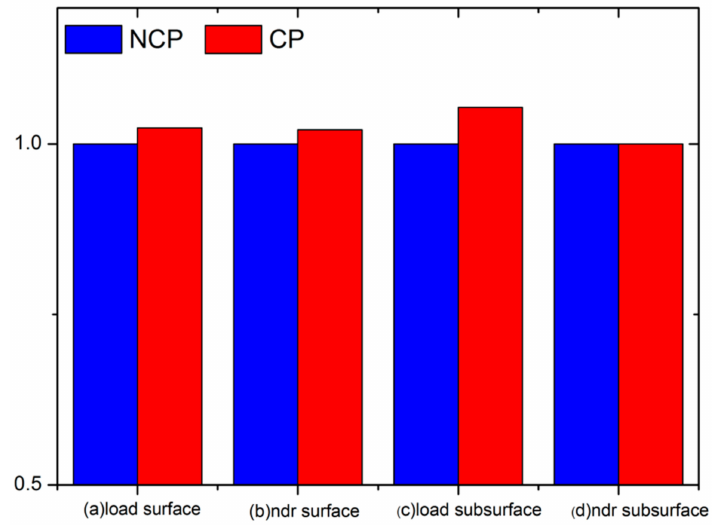
Figure 6. The value of variables in NDR model in different